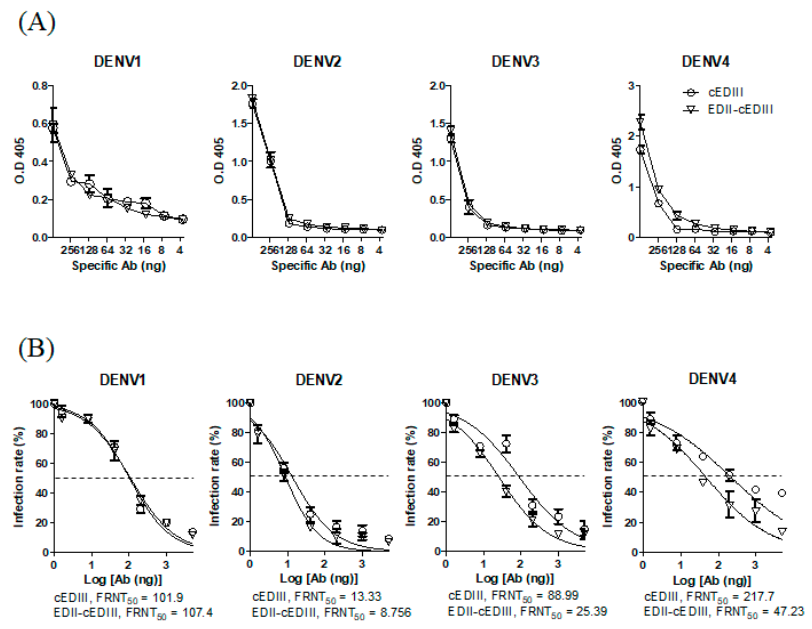
Figure 1. Effects of antibodies (Abs) on dengue virus (DENV) infection in Vero E6 cells. ( A ) Binding of Ab to DENV was measured using purified IgG against consensus envelope domain III (cEDIII) and envelope domain II (EDII)-cEDIII by enzyme-linked immunosorbent assay (ELISA) of the endpoint titer. Circles and inverted triangles represent anti-cEDIII and anti-EDII-cEDIII Ab-treated groups, respectively. ( B ) Neutralization endpoint titer of purified Ab against DENV serotypes by foci reduction neutralization assay in Vero E6 cells. Nonlinear regression (curve fit) was performed using GraphPad Prism software. Dotted line, 50% infection rate (FRNT 50 ) calculated using Prism software. A representative result from three to five independent experiments is shown.